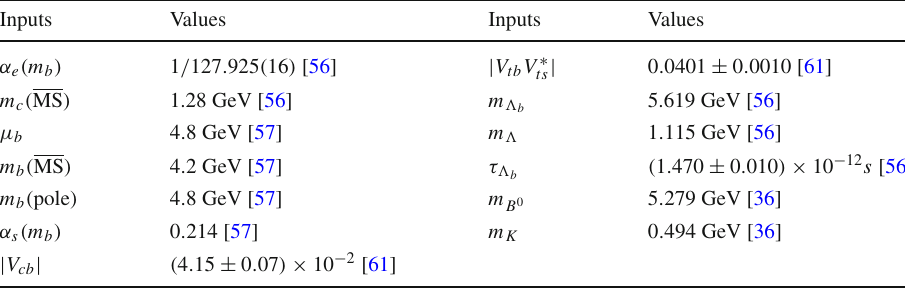
Table 1 List of inputs and their